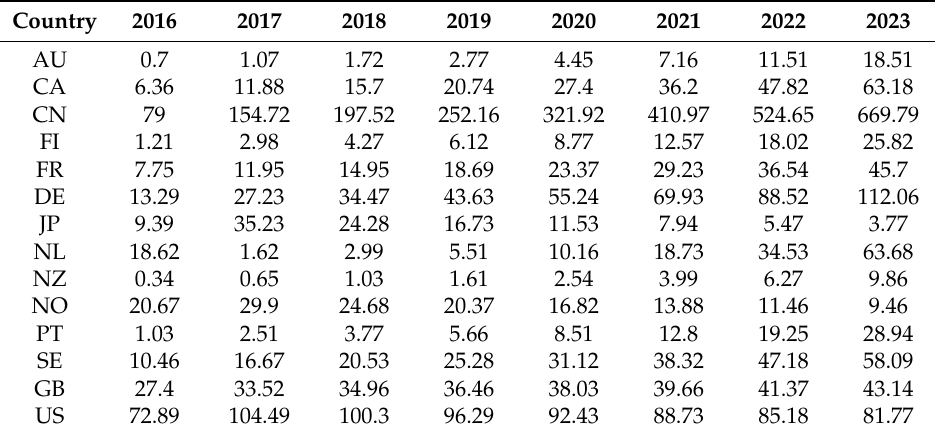
Table 8. The forecasted values of